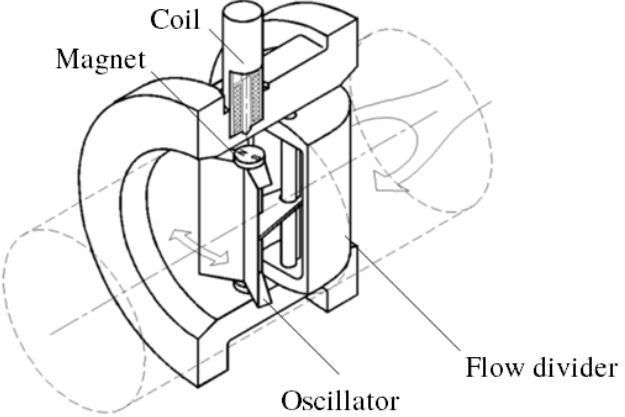
Figure 1. Main components of a mechanical oscillator flowmeter.